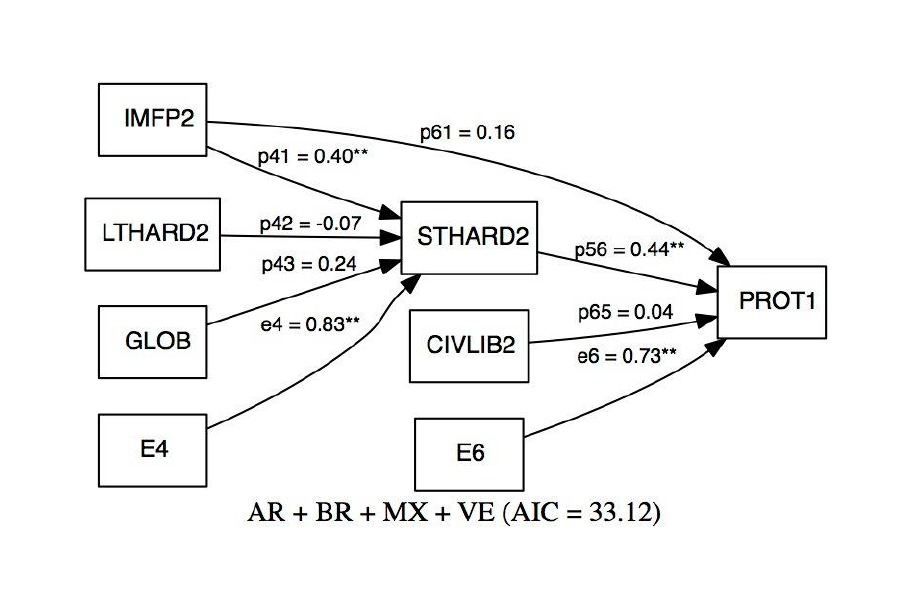
Figure 1. Best Multimodel (*p <= 0.05, **p <=